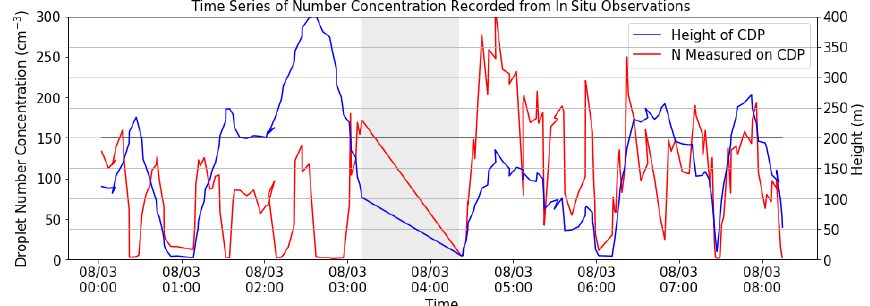
Figure 8. The total cloud droplet number concentration recorded by the CDP throughout the fog event observed on 7–8 March 2020, with the height of the instrument shown on the same graph. The number concentration assumed in the retrieval of 150cm − 3 is highlighted with the black line.